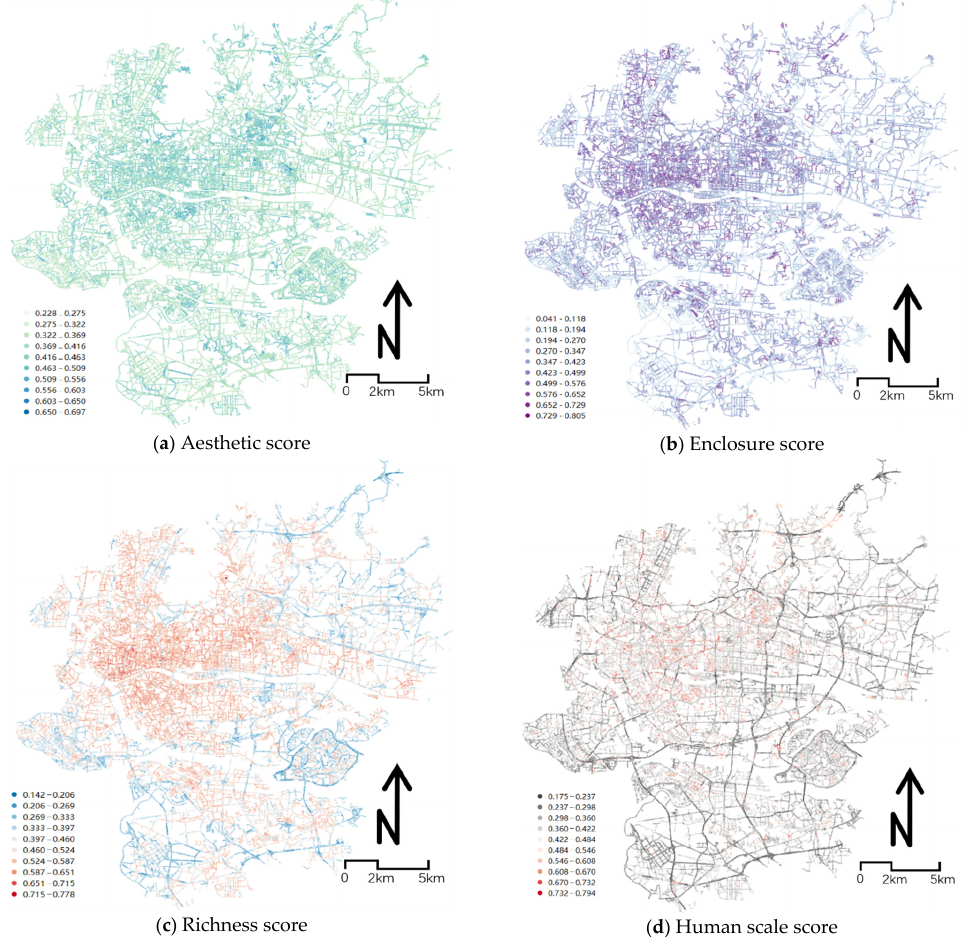
Figure 5. The spatial distribution of selected streetscape perception indices.